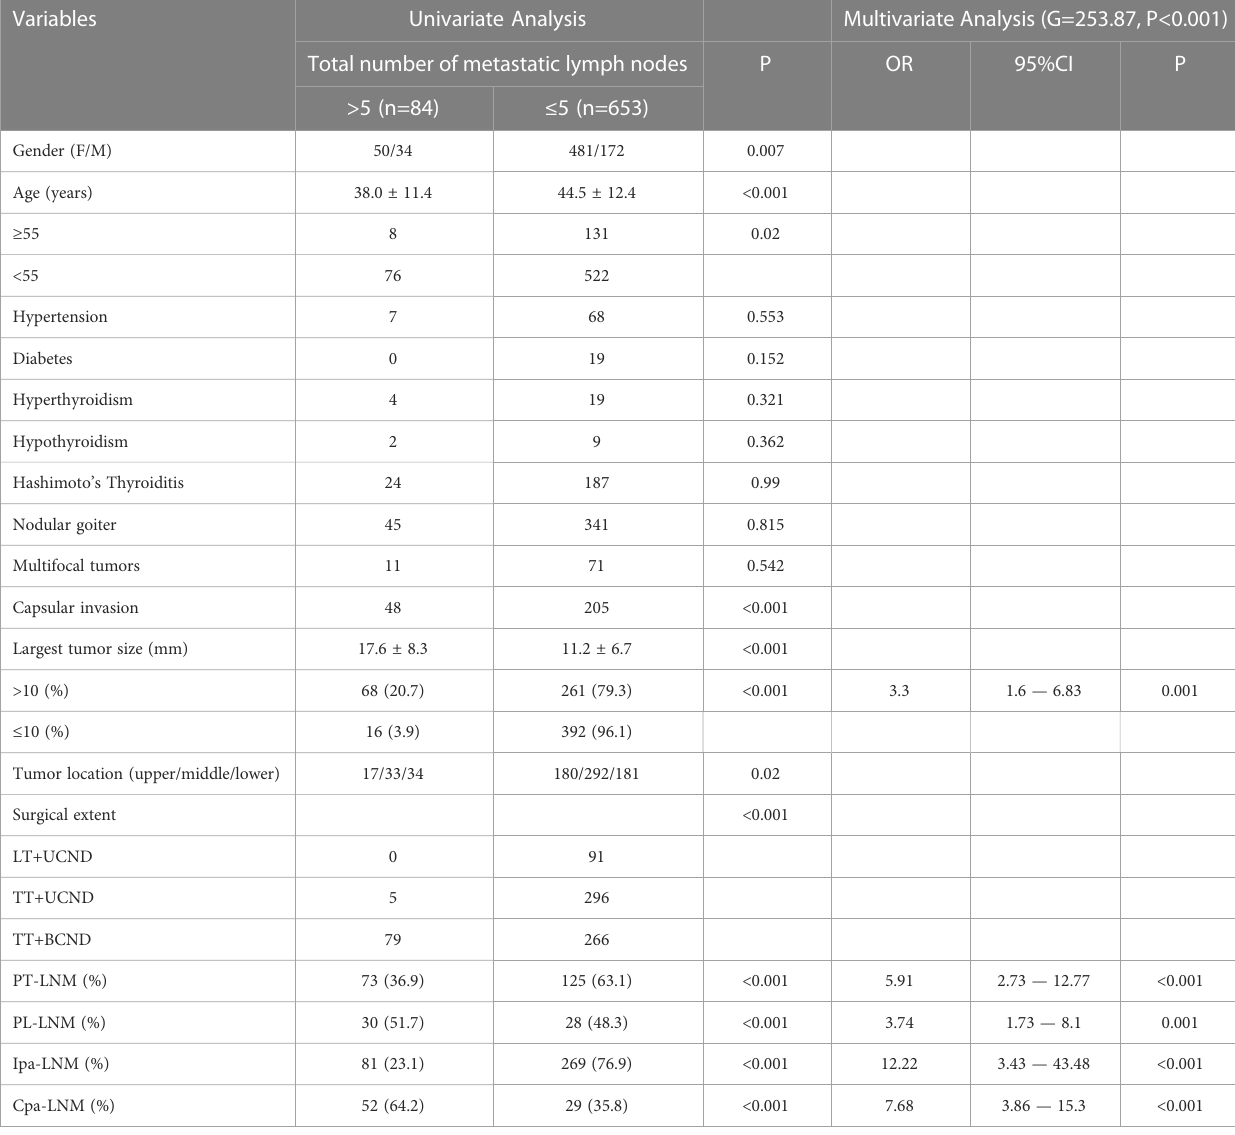
TABLE 5 The risk factors for more than 5 metastatic central lymph nodes.